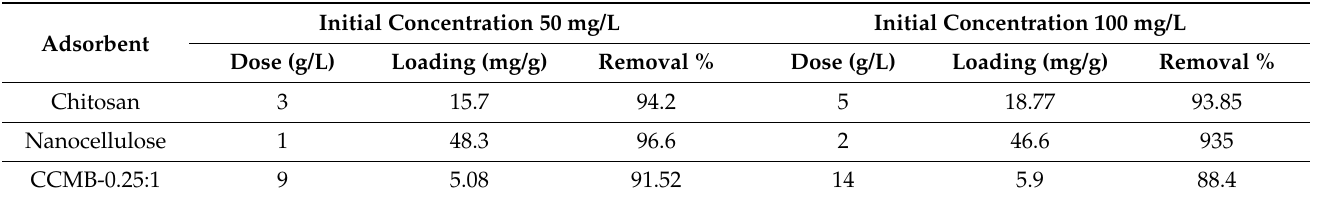
Table 2. Optimal adsorbent concentrations for direct blue 78 dye removal.